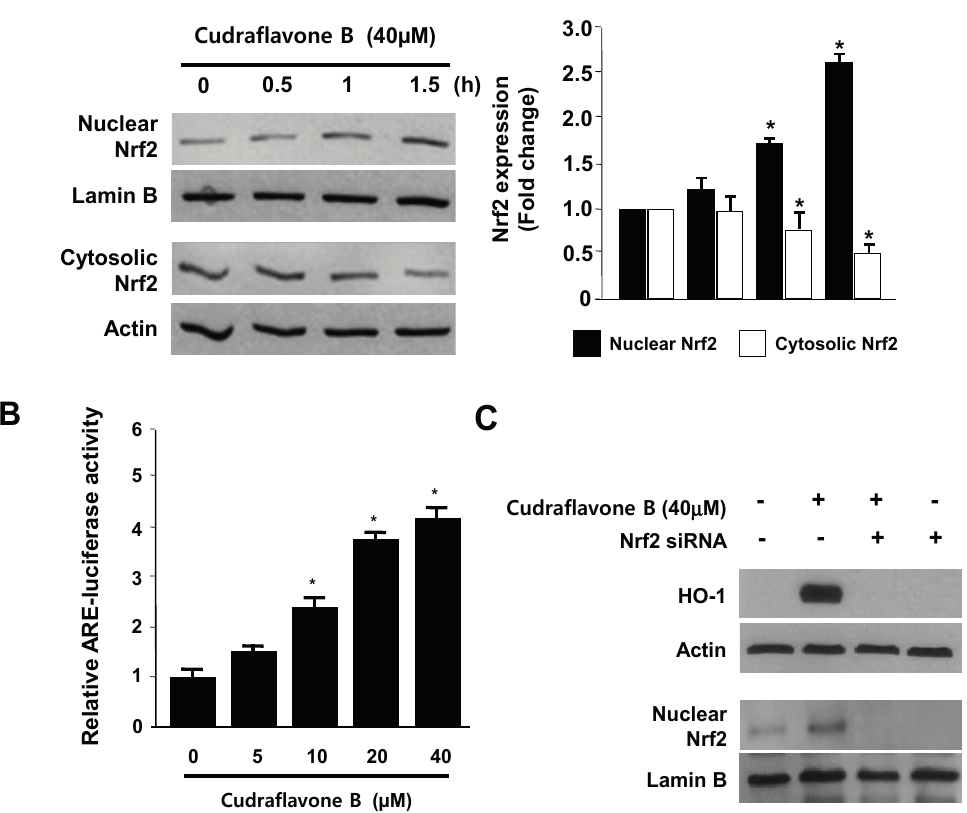
Figure 4. Effects of cudraflavone B on the nuclear translocation of Nrf2 ( A ); ARE activation ( B ); and Nrf2-mediated HO-1 expression ( C ) in HT22 cells. HT22 cells were treated with cudraflavone B (40 μ M) for 0.5, 1, and 1.5 h ( A ); Quiescent cells transiently transfected with ARE-luciferase or control vector were incubated for 1 h with indicated concentrations of cudraflavone B in the presence of 5% FBS ( B ); HT22 cells were transiently transfected with Nrf2 siRNA and then treated with cudraflavone B (40 μ M) for 12 h (HO-1) or 1.5 h (Nuclear Nrf2) ( C ). Data are presented as the mean value ± SD values of three independent experiments. * p < 0.05 vs.